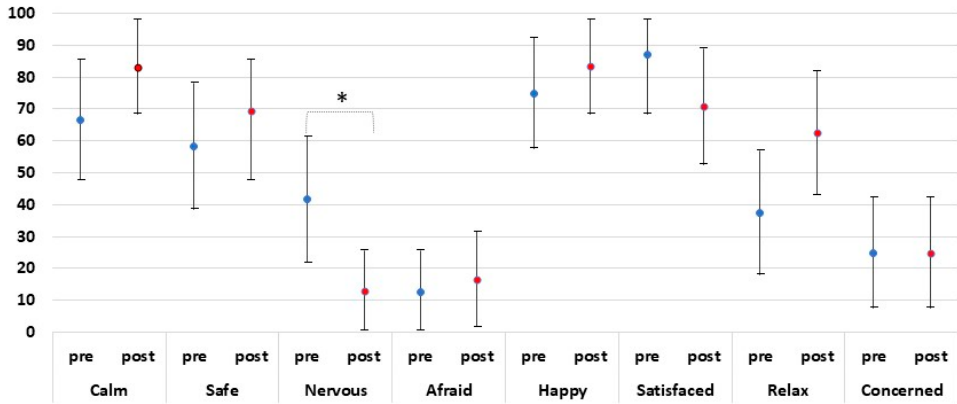
Figure 3. Comparison among self-perceived feelings pre- and post-CPR (CI 95%). * Statistically significant differences ( p < 0.01 before vs. after) are shown.